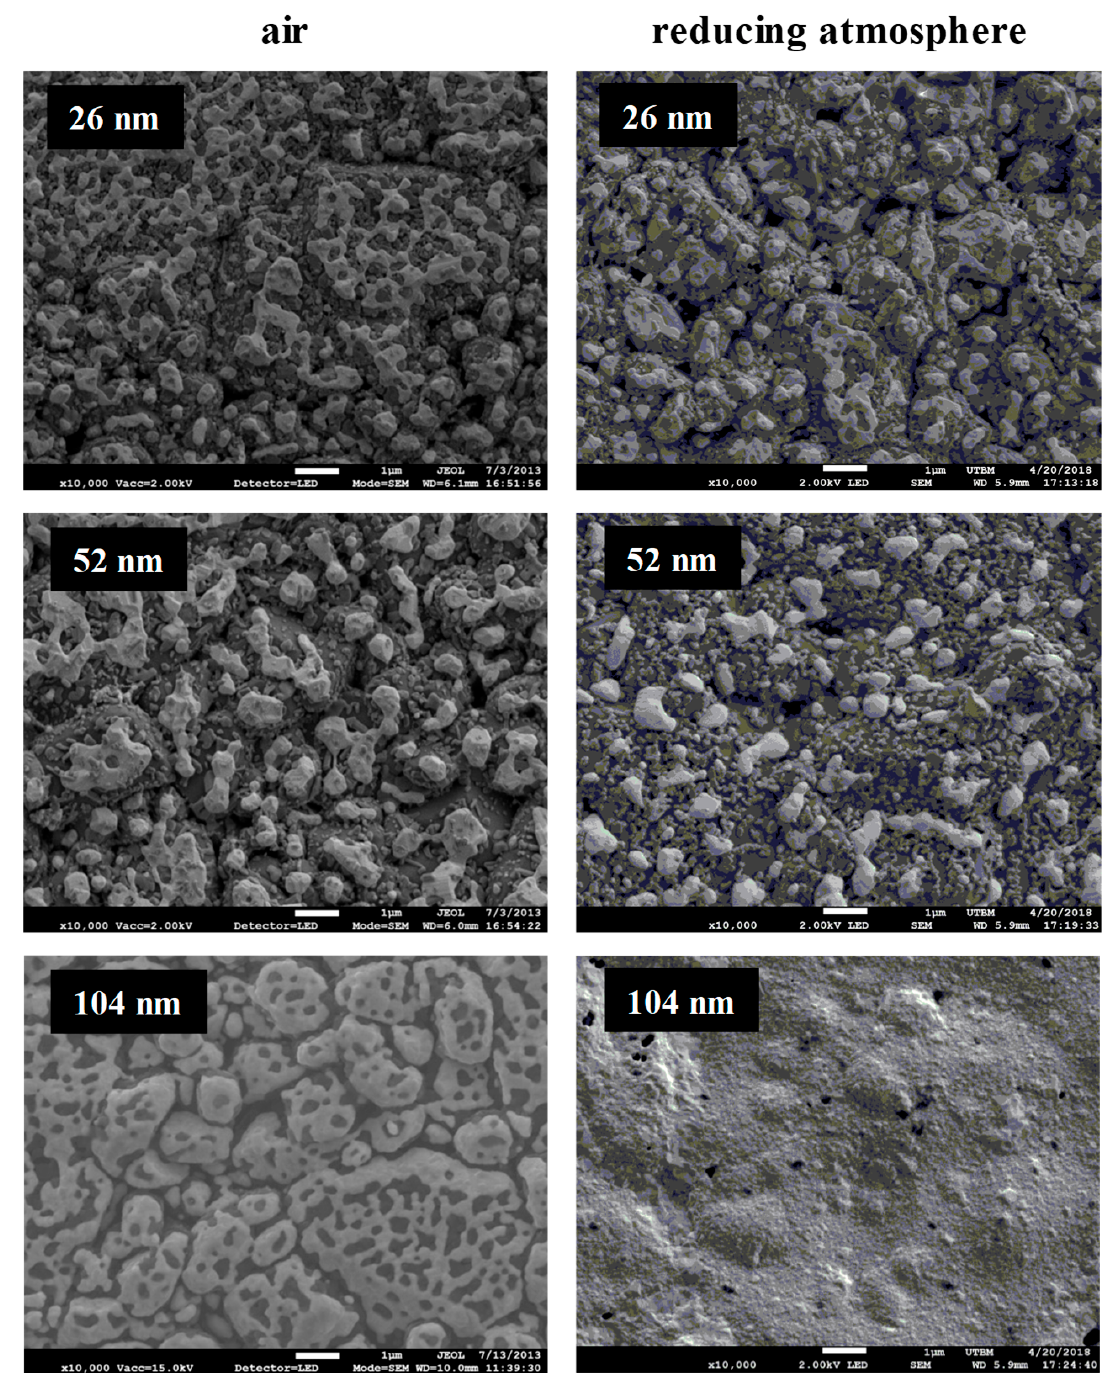
Figure 8. SEM micrographs of the top surface of Pt 3 Ti coatings with different thicknesses after the resistivity measurements under air and under reductive atmosphere at 1273 K.